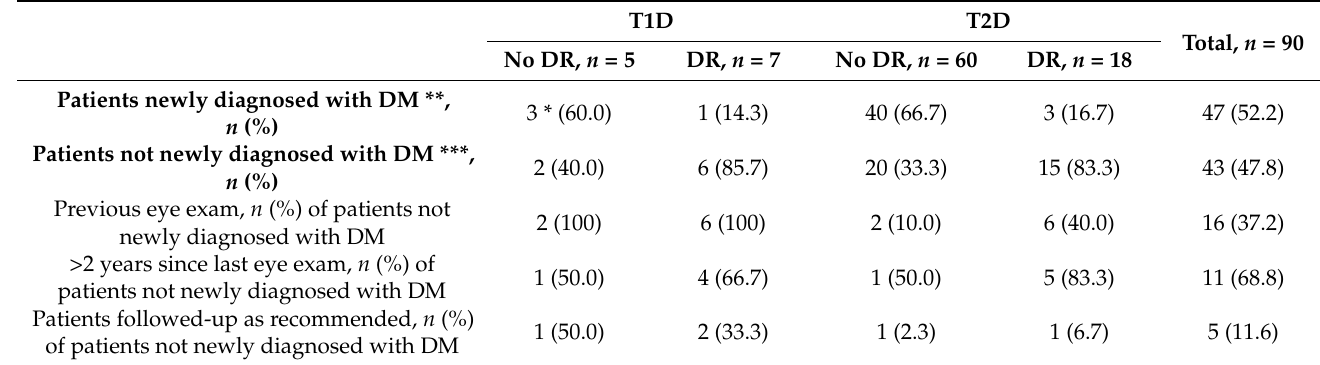
Table 2. Screening history of the studied